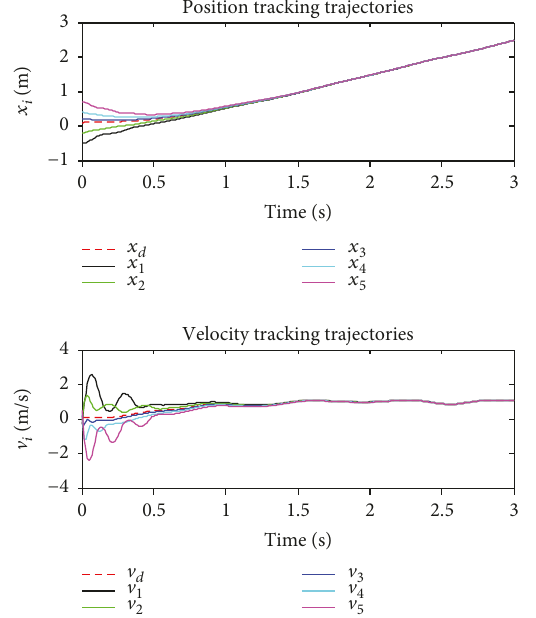
Figure 4: State tracking trajectories for Case 3.